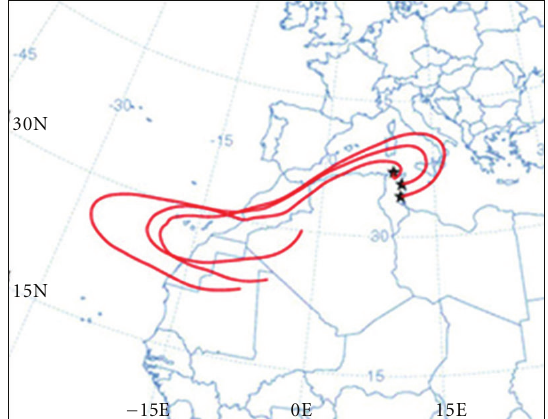
Figure 4: Sample of back-trajectories maps of Saharan event ending over the Mediterranean Tunisian regions at 1200 UTC. ((NOAA)’s Air Resources Laboratory